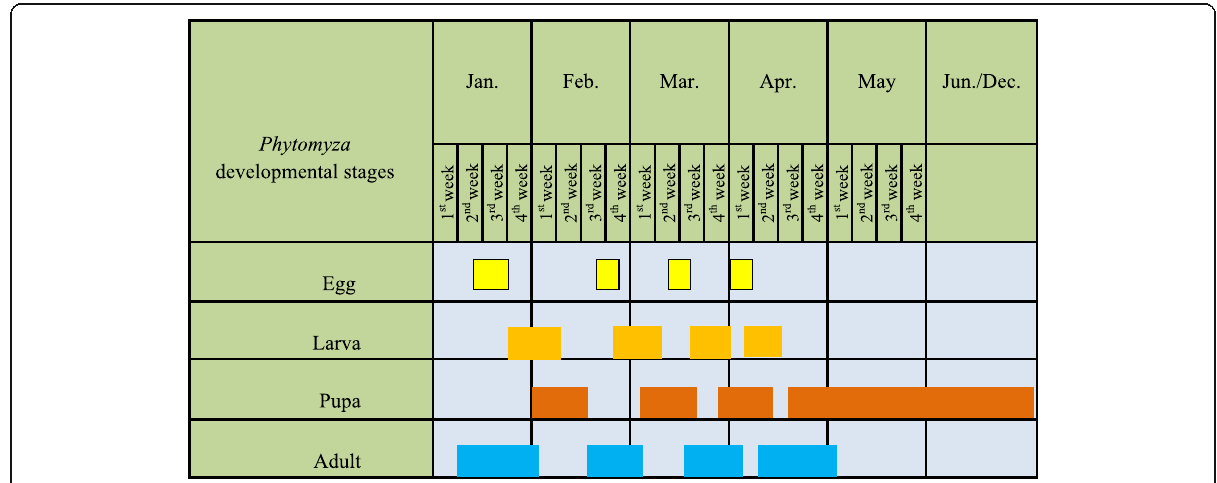
Fig. 2 Phenological stages of Phytomyza orobanchia on Orobanche crenata parasitizing on faba bean crop showing four generations